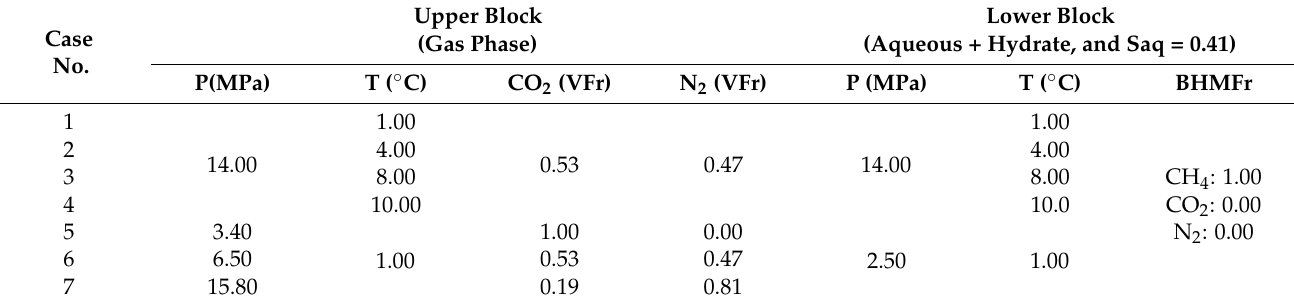
Table 6. Cases used in the verification.